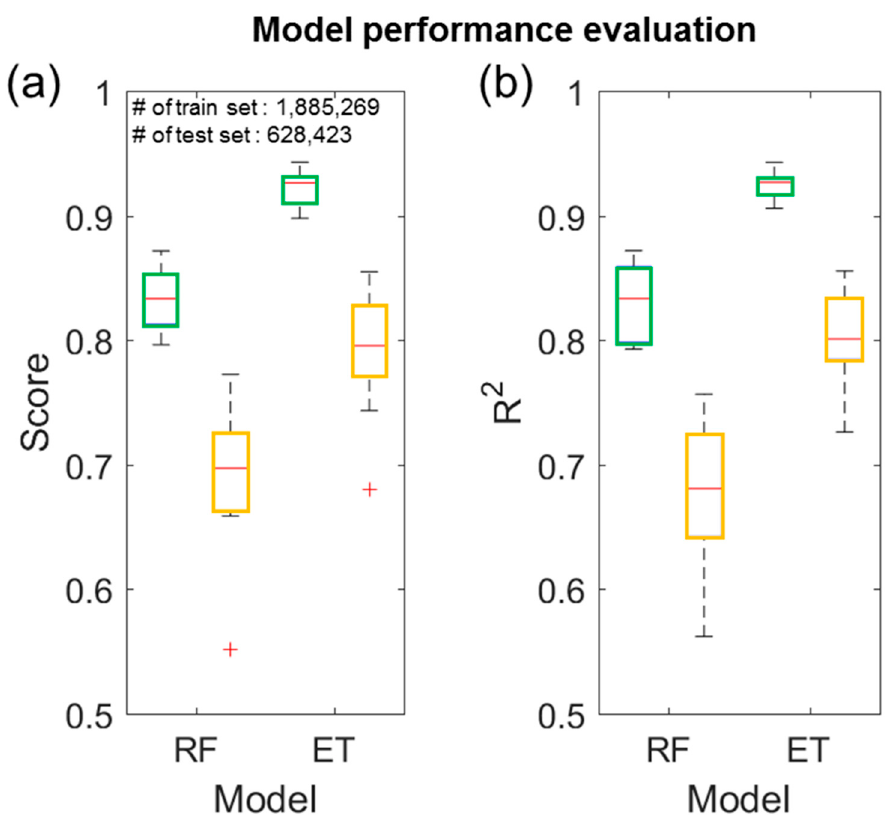
Figure 3. Comparison between the Random forest (RF) and Extremely Randomized Tree (ET) model performances using: ( a ) score; and ( b ) coefficient of determination (R 2 ). The green- and orange-colored boxes are the performance results for training and test datasets, respectively. In the boxplot, the top and bottom sides of the box represent 25 percentile and 75 percentile in the interquartile range, respectively. The red line in the box means the median value, the black horizontal bars at the top and bottom indicate the minimum and maximum, and the red crosses indicate outliers.